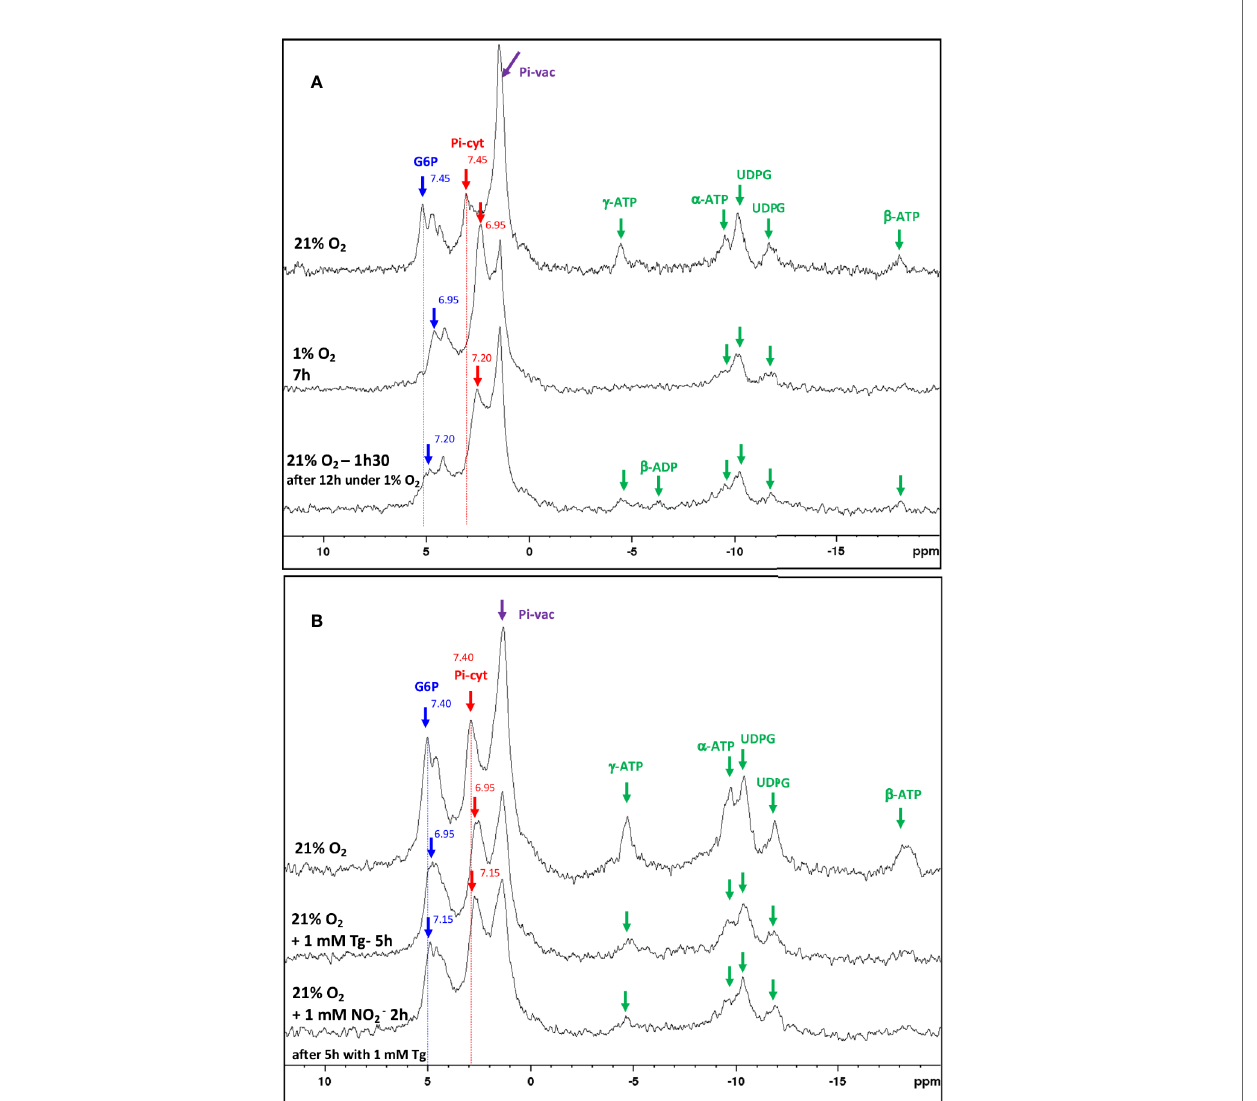
FIGURE 8 | In vivo 31 P-NMR study of metabolic transitions induced in Medicago truncatula nodules. (A) Proton-decoupled 31 P-NMR spectra of nodules in normoxia at 21°C, perifused with a nutritive medium at pH 6.0 with successively 21% O 2 (control), 1% O 2 , and then 21% O 2 . For each line, duration of the treatment is indicated up to the end of the spectrum. (B) Proton-decoupled 31 P-NMR spectra of nodules in normoxia at 21°C, perifused with a nutritive medium at pH 6.0 containing successively 21% O 2 (control), 1 mM tungstate (Tg) for 5 h, and then 1 mM nitrite (NO 2 − ) for 2 h. For each line, duration of the treatment is indicated up to the end of the spectrum. Each spectrum series is drawn from a representative experiment of eight (A) and fi ve (B) biological replicates. The values indicated next to the G6P and Pi-cyt resonances correspond to the cytosolic pH values. Exponential apodization and zero fi lling. Pi, inorganic phosphate; G6P, Glucose-6-phosphate; Pi-cyt, cytoplasmic Pi; Pi-vac, vacuolar Pi; UDPG,